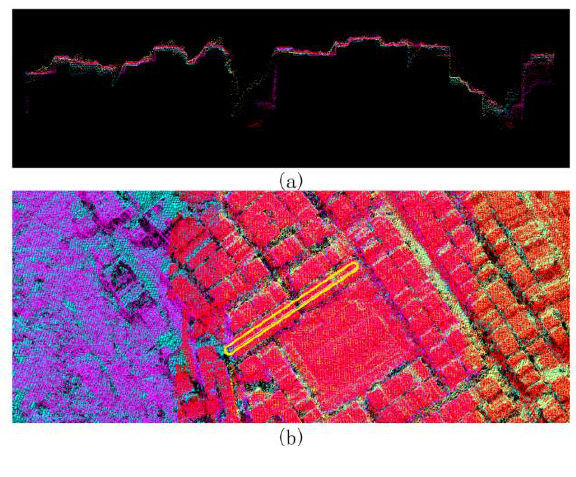
Figure 1. Inconsistencies in the point cloud data from different stereopairs, and different colors represent from different stereopairs; (a) Cross section of point cloud data in the yellow rectangle of (b); (b) Top view of point cloud